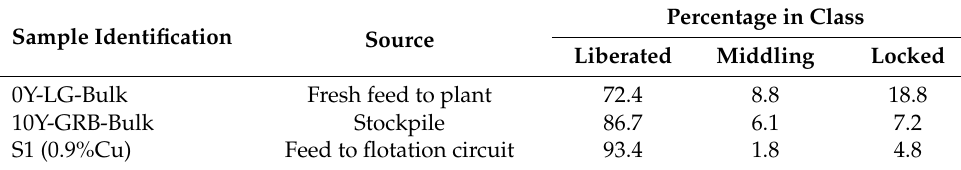
Table 6. Liberation of chalcopyrite in selected